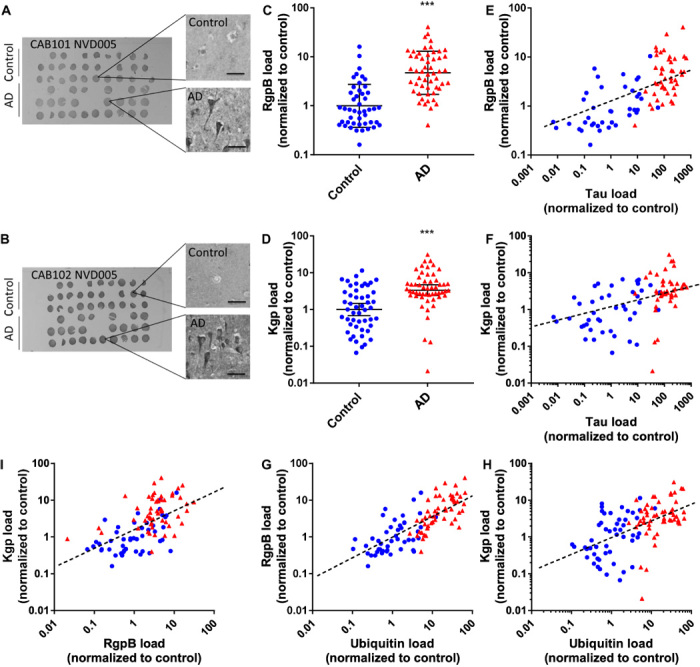
Gingipain IR in brain correlates with AD diagnosis and pathology.(A and B) Representative TMA NVD005 containing brain tissue cores from the MTG of AD patients and controls probed for RgpB (A) and Kgp (B) with antibodies CAB101 and CAB102, respectively. Higher magnification of representative tissue cores reveals higher neuronal RgpB-IR and Kgp-IR in AD tissue cores than in control cores. (C) RgpB-IR and (D) Kgp-IR data from TMAs NVD005 and NVD003 show significantly higher load in AD brain compared to controls. Mann-Whitney test, ***P < 0.0001; presented as geometric mean ± 95% confidence interval, n = 99 (C) and n = 104 (D). (E and F) Tau load correlates to RgpB load (Spearman r = 0.674, P < 0.0001, n = 84) (E) and Kgp load (Spearman r = 0.563, P < 0.0001, n = 89) (F). Blue, control; red, AD. (G and H) Ubiquitin load, a marker of AD pathology, correlates to RgpB load (blue, control; red, AD; Spearman r = 0.786, P < 0.0001, n = 99) (G) and Kgp load (Spearman r = 0.572, P < 0.0001, n = 104) (H). (I) RgpB load correlates with Kgp load (Spearman r = 0.610, P < 0.0001, n = 99).